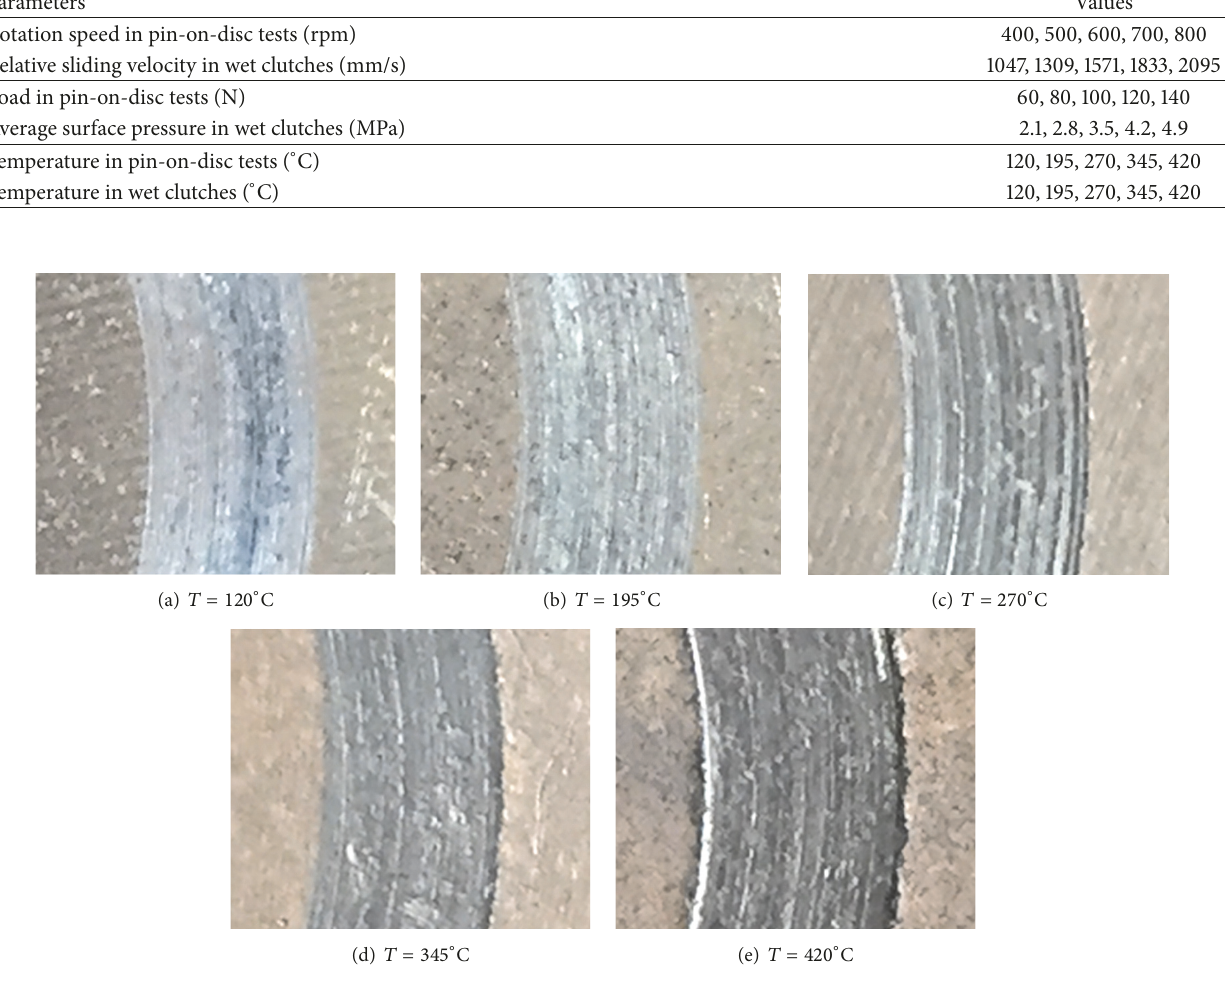
Figure 3: Friction discs after tests with different levels of